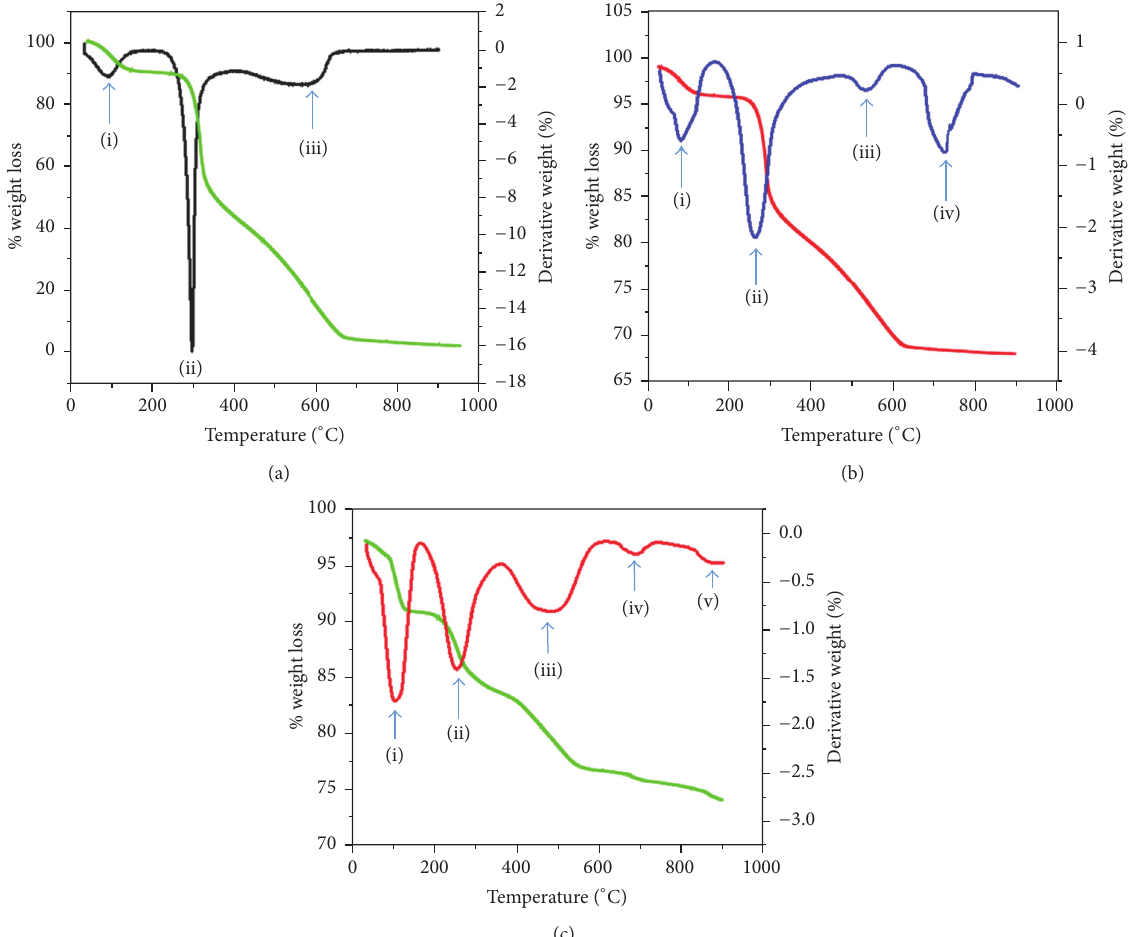
Figure 6: TGA and TGA derivative curves of chitosan (a), chitosan-alumina (b), and chitosan-alumina/f-MWCNTs (c) nanocomposites.